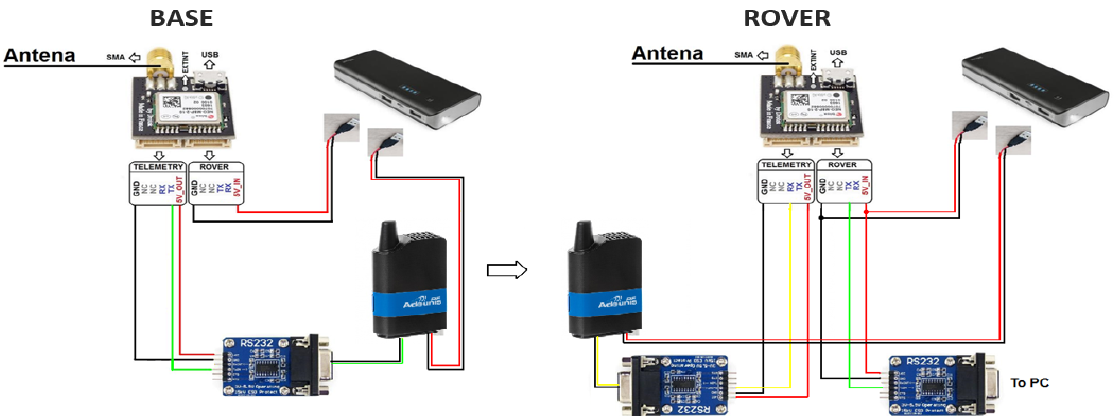
Figure 11. Diagram of systems for the transmission of RTK corrections from a reference station to a mobile measurement system.